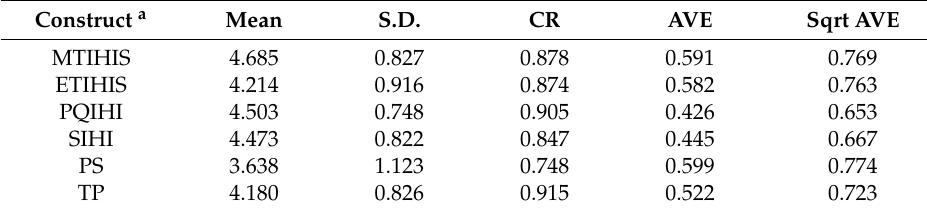
Table 4. Mean, SD, CR and AVE.